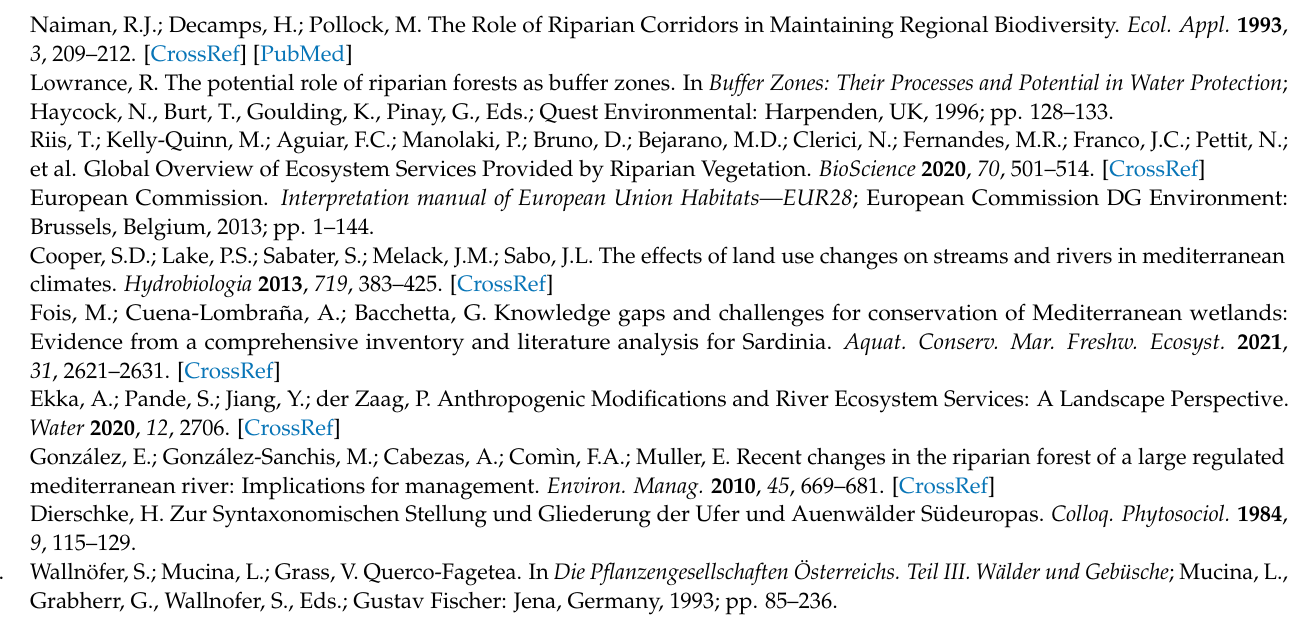
Table 3. Rel. 1, Appennino pistoiese, Marliana (28.4.2009) (Foggi et al.); Rel. 2, Appennino pistoiese, Pistoia (21.7.2009) (Foggi et al.); Rel. 3, Appennino pistoiese, Montale (22.7.2009) (Foggi et al.); Rel. 4, Appennino pistoiese, Montale (22.7.2009) (Foggi et al.); Rel. 5, Appennino pratese, Montemurlo (22.7.2009) (Foggi et al.); Rel. 6, Appennino pistoiese, Pistoia (30.7.2009) (Foggi et al.); Rel. 7, Appennino pistoiese, Pistoia (30.7.2009) (Foggi et al.); Rel. 8, Appennino pistoiese, Marliana (31.7.2009) (Foggi et al.); Rell. 9–11, Appennino pistoiese, Pescia (11.6.2009) (Foggi et al.); Rell. 12–14, Appennino aretino,